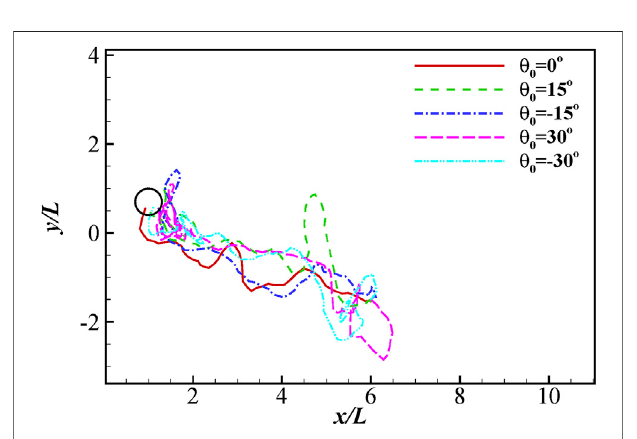
FIGURE 7 | The traces of the head for different initial orientation angles. FIGURE 8 | The time change of the lateral tail tip movement in the local coordinate